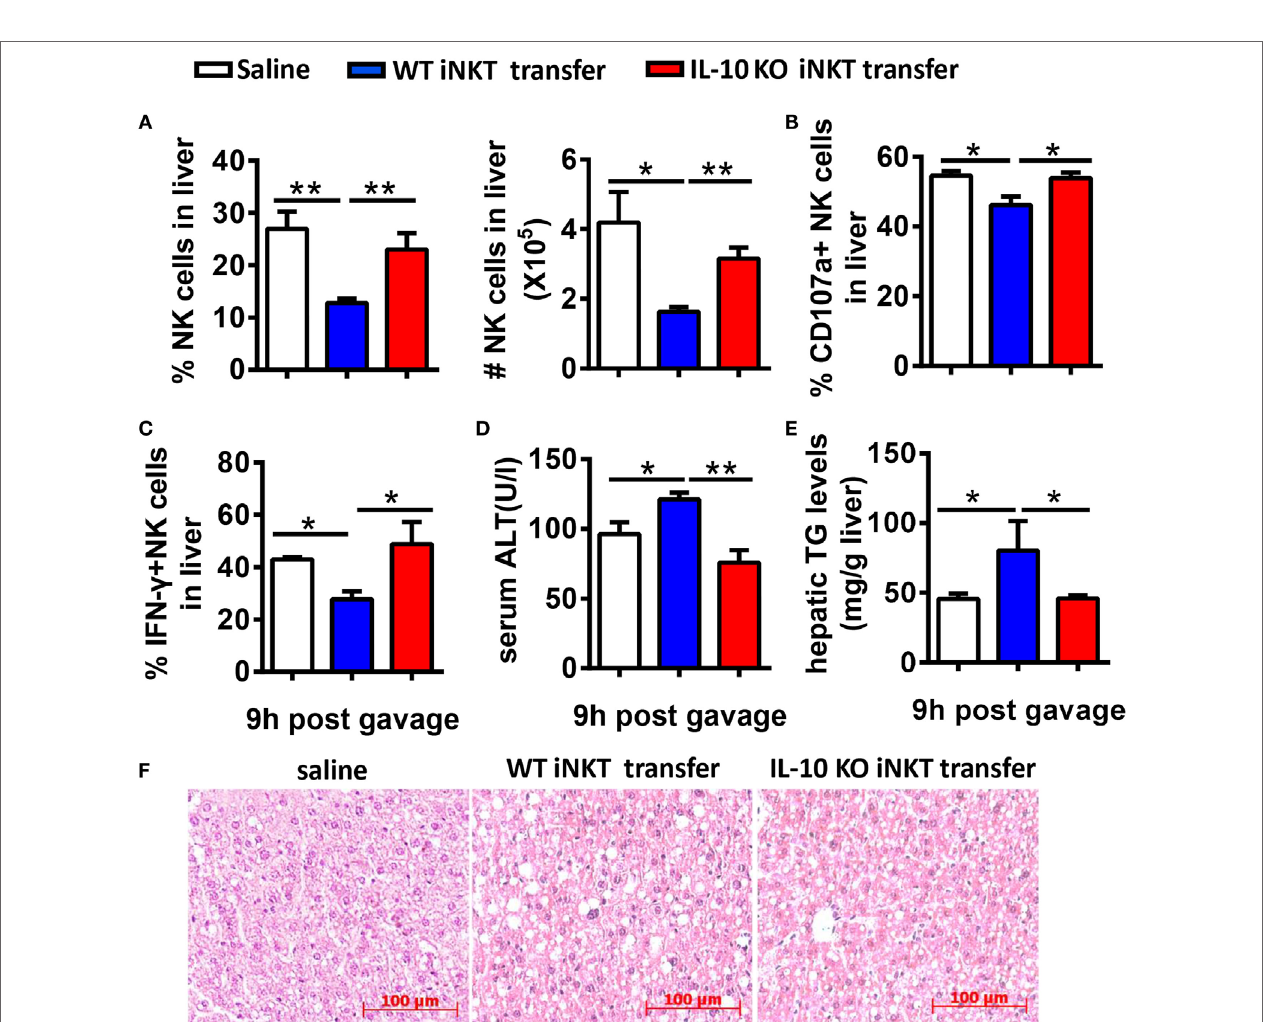
FigUre 13 | Adoptive transfer of interleukin-10 (IL-10) − / − cells, but not wild-type (WT) invariant natural killer T (iNKT) cells, restored NK cell accumulation, and function in J α 18 − / − mice. J α 18 − / − mice were fed ethanol diets for 10 days, followed by gavage with a single dose of ethanol and the intrasplenic adoptive transfer of iNKT cells (5 × 10 5 cells) purified from the livers of WT or IL-10 − / − mice. The mice were sacrificed 9 h after gavage. (a–c) Liver mononuclear cells were isolated. (a) The percentage and absolute number of NK cells among all leukocytes in the liver. (B) CD107a expression (with PMA stimulation) and (c) interferon- γ release (with PMA stimulation) from hepatic NK cells were detected by flow cytometry and were statistically analyzed. (D–F) Liver injury and steatosis were evaluated based on (D) serum alanine aminotransferase and (e) liver triglyceride levels and (F) liver tissue hematoxylin and eosin staining (original magnification, 200 × ). The data are representative of two independent experiments and are shown as the mean ± SEM ( n = 3–7). * P < 0.05; ** P <